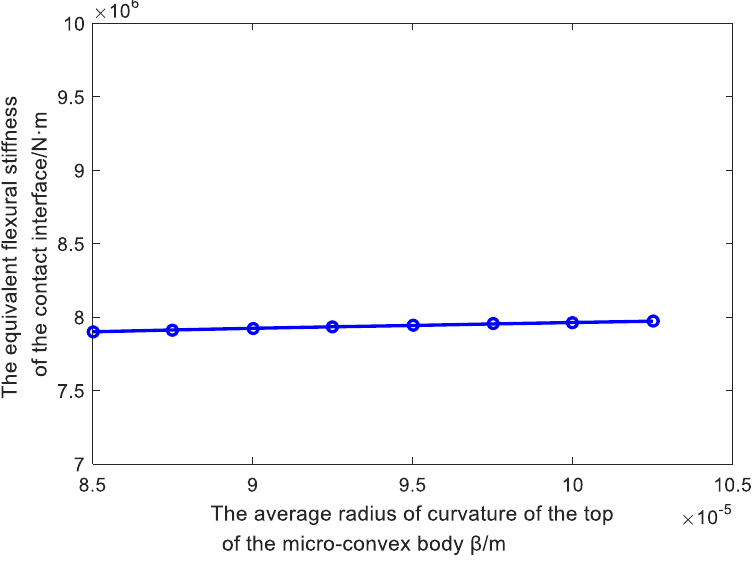
Figure 9. EFS of the contact surface changes with the average micro-convex body radius of curvature of the top.